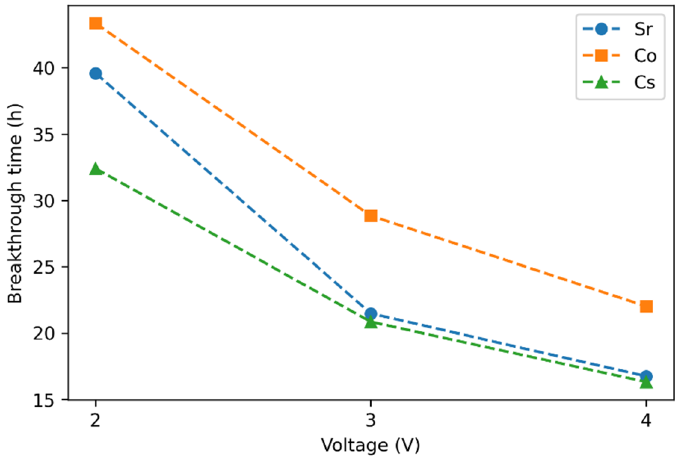
Figure 8. Comparison of breakthrough time for Sr, Cs and Co under different tested voltages.